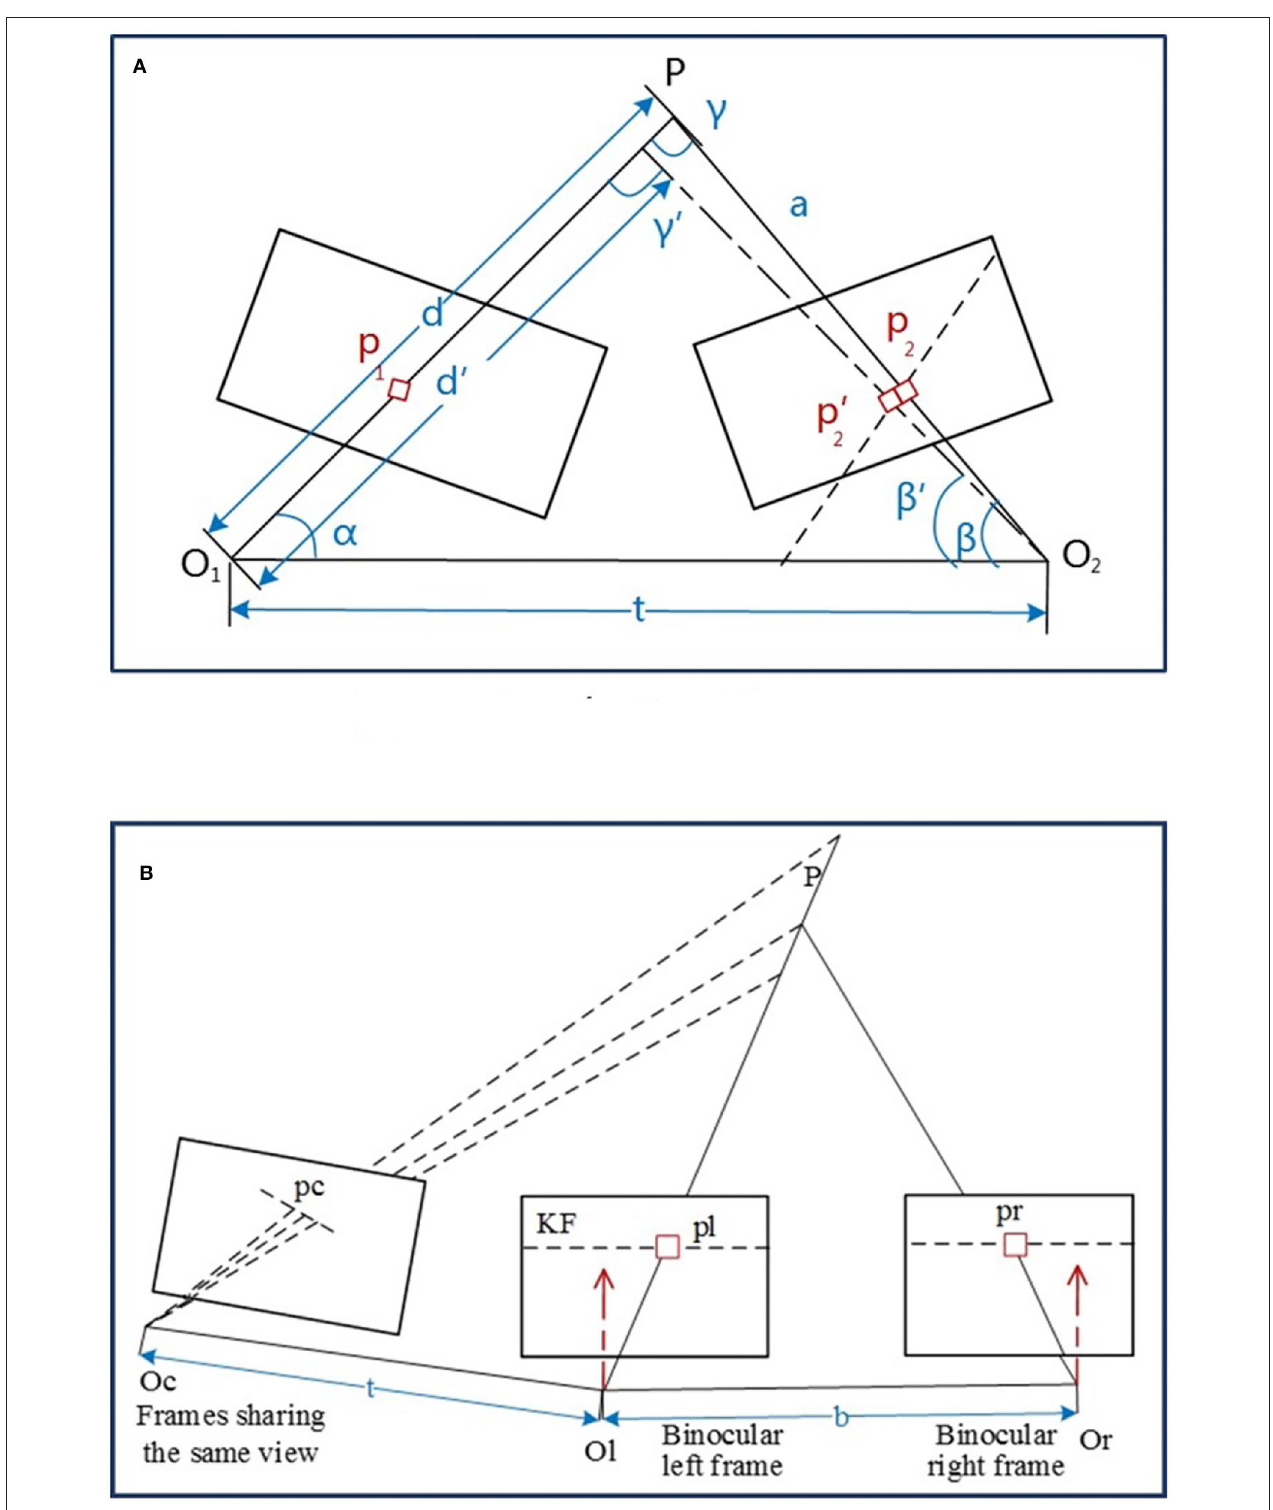
FIGURE 4 | The illustration of depth estimation. (A) Depth estimate with uncertainty. (B) Spatial point depth estimate.